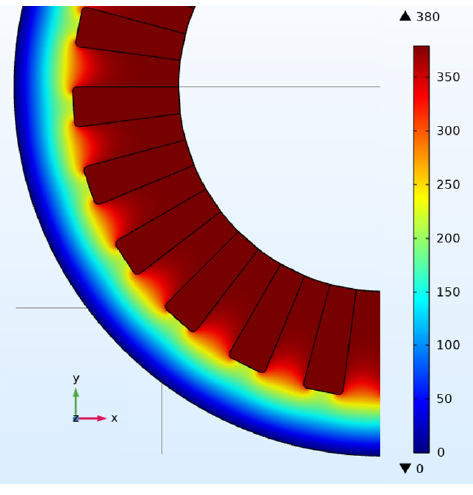
Figure 6. Distribution of the electrical